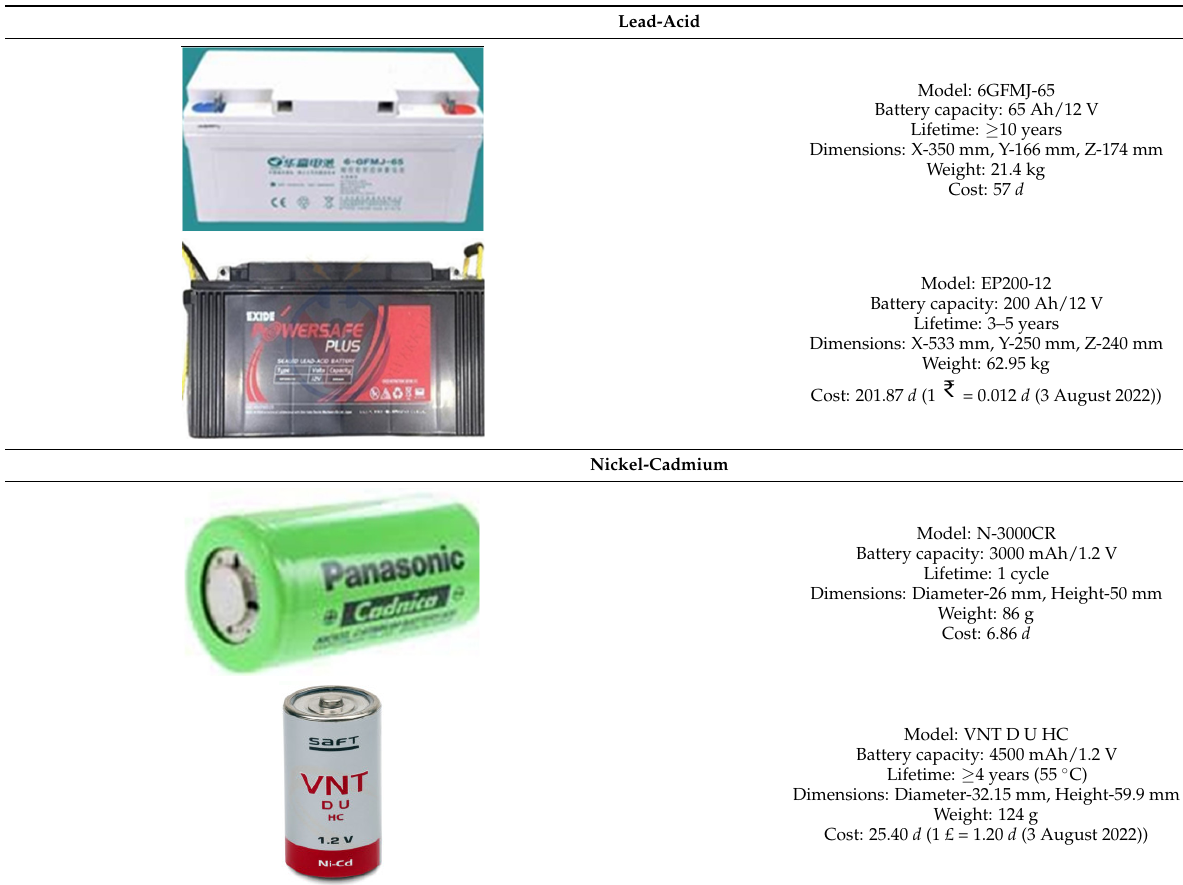
Table A1. Commercial examples of conventional batteries. Data provided by the manufacturer.